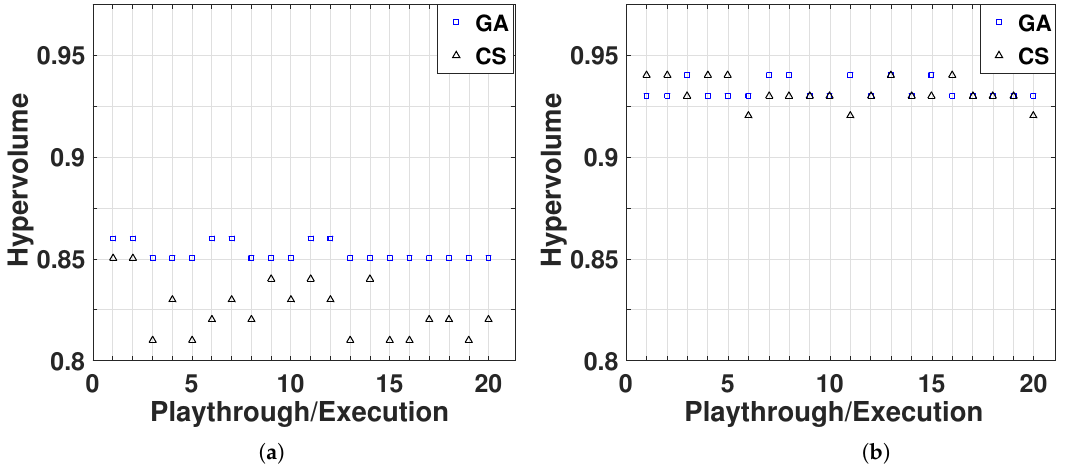
Figure 12. Computed hypervolume after solving the Facility Location Problem (FLP) by using the crowdsourcing approach and genetic algorithms (GA) for Swain ( a ) and London ( b )